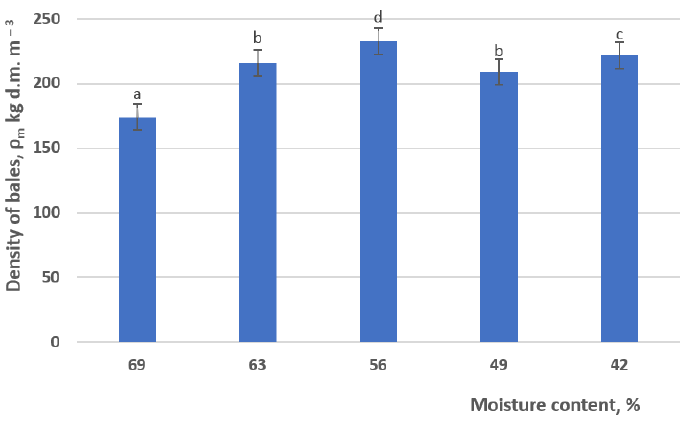
Figure 6. Bar chart of balage density in bales at different moisture content levels at a pressing pressure of 18 MPa and plant material at a length of 183 mm. Different lowercase letters indicate a statistically significant difference at p ≤ 0.05. d.m, dry matter.